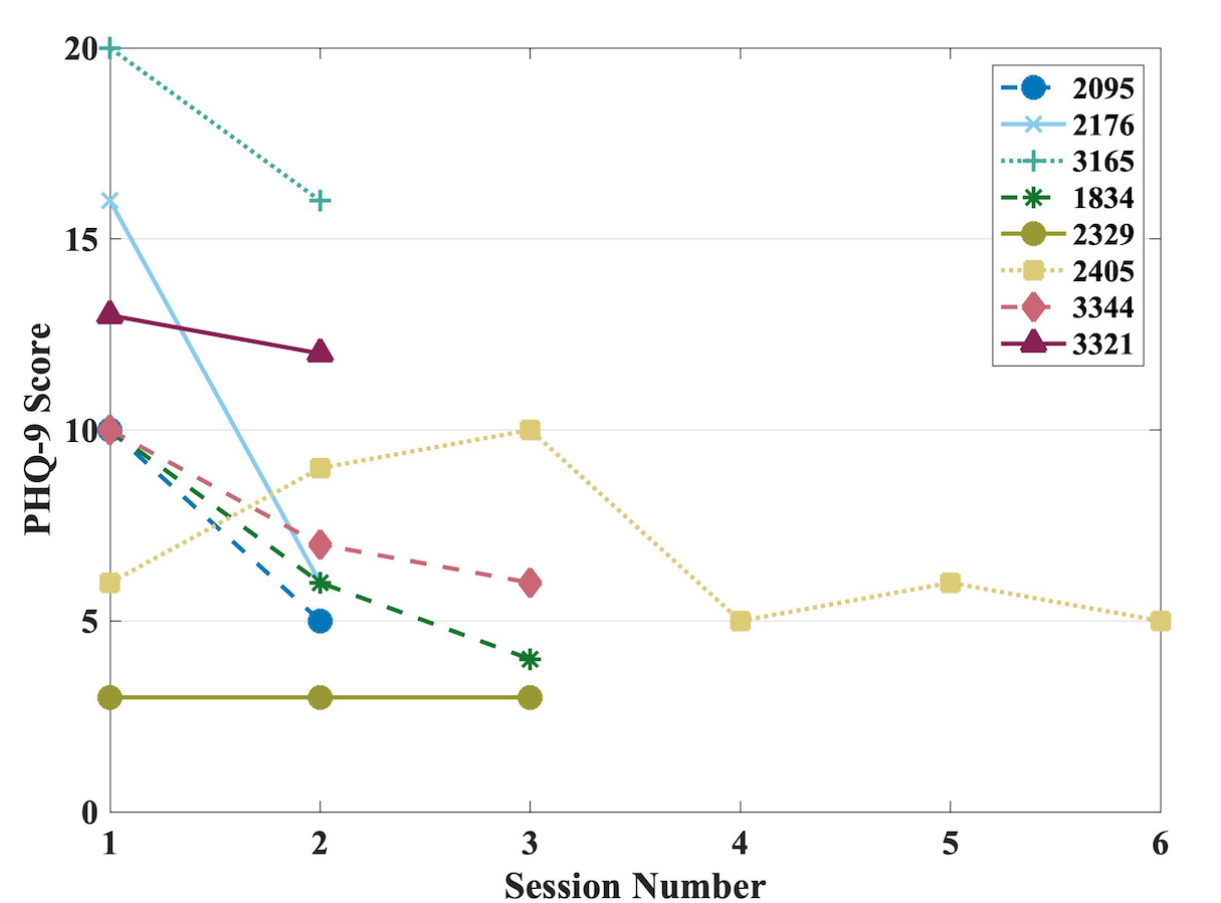
Figure 6. Change in depression during sessions one through six measured with PHQ-9 scores. The figure legend's four-digit values correspond to